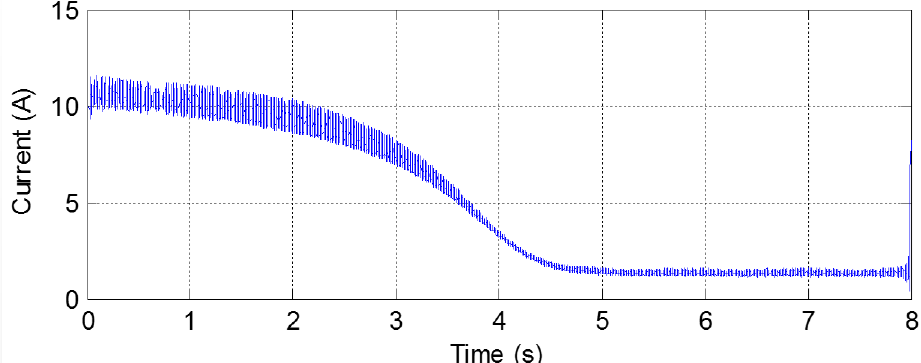
Figure 15. Envelope of start-up current extracted by means of HT.